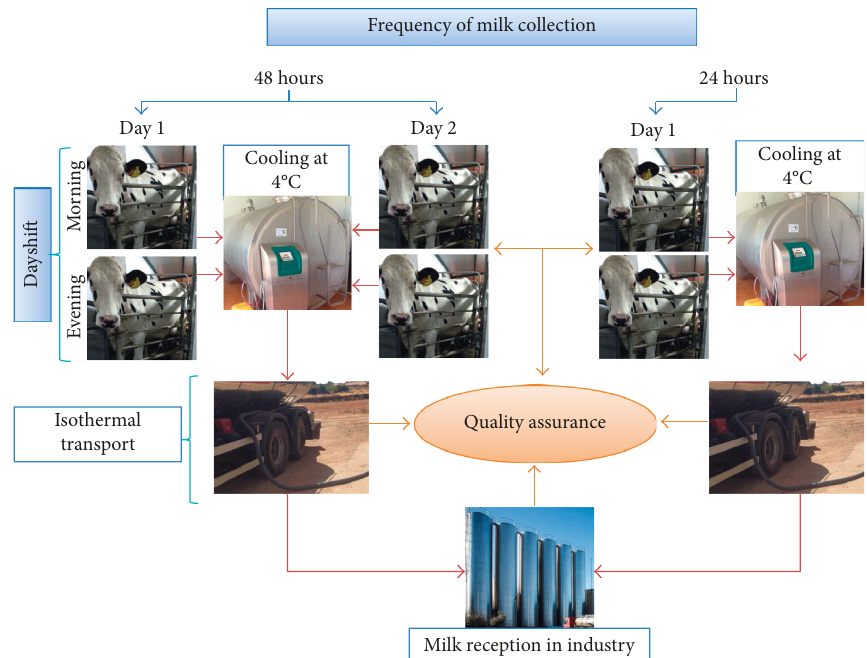
Figure 1: Steps in the milk primary production chain from the farm to the dairy industry considering two frequencies of milk collection at the farm (i.e., 24 and